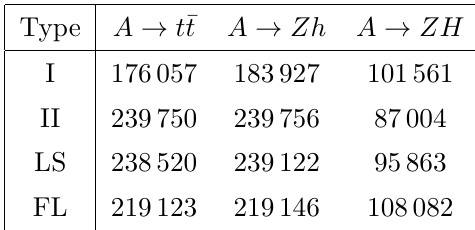
Table 12 . Number of parameter points available for the analysis in the individual OS decay channels of the pseudoscalar Higgs boson A ( h is